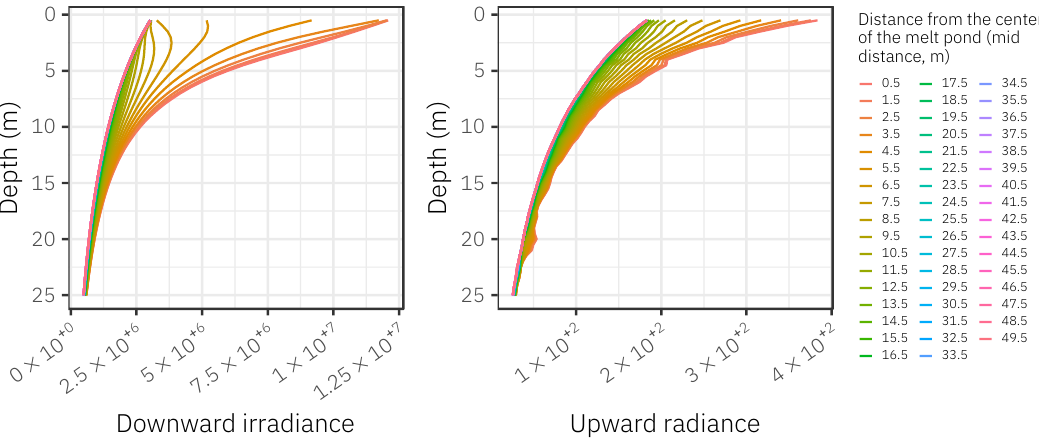
0.080.100.120.14